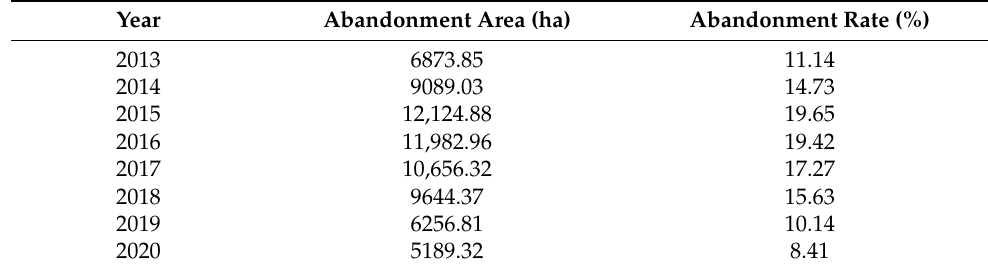
Figure 7. Spatial distribution of abandoned cropland in Gaolan County. Table 3. Statistical results regarding abandoned cropland in Gaolan County from 2013 to 2020.